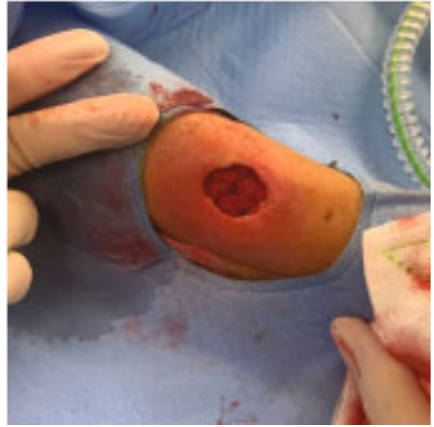
Figure 2: Debridement to the level of the muscle.